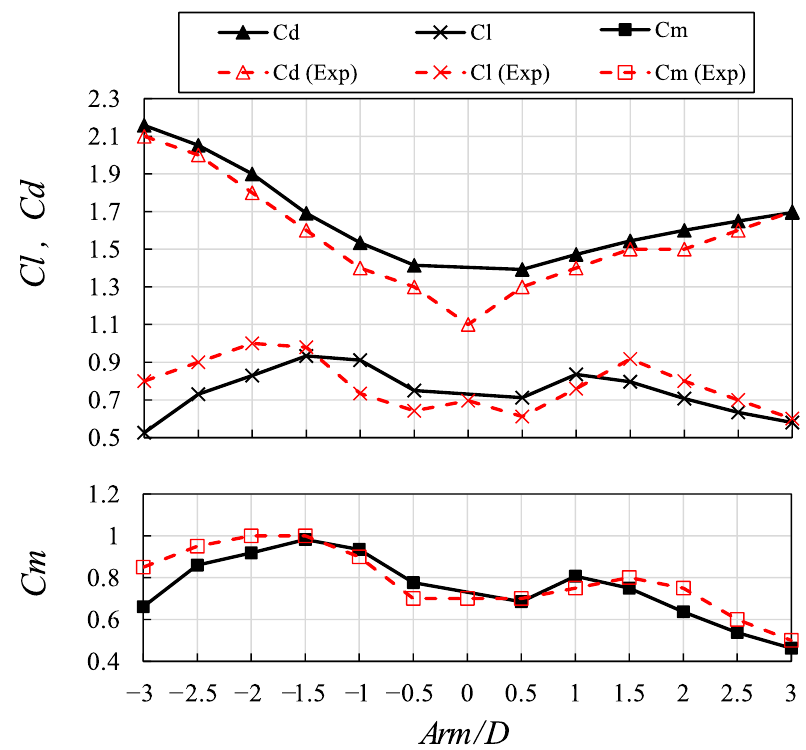
Figure 6. Comparison between the numerical results and